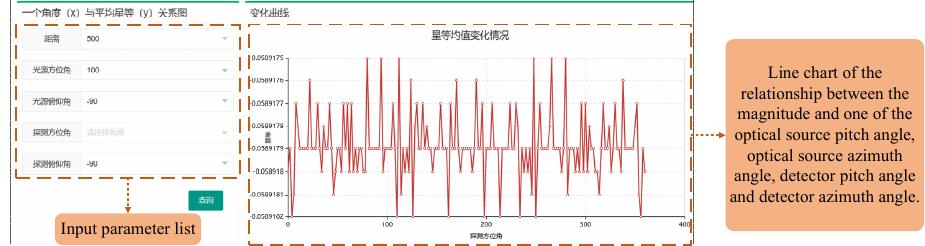
Figure 16. Line chart of magnitude changes of the Worldview 1 satellite with the detector azimuth when the optical source pitch, optical source azimuth, and detector pitch are fixed. In this figure, the values of optical source pitch, optical source azimuth, detector pitch, and equivalent distance are − 90°, 100°, − 90°, and 500 km, respectively. In the heatmap, the x -axis is the detector azimuth and the y -axis is the magnitude value.